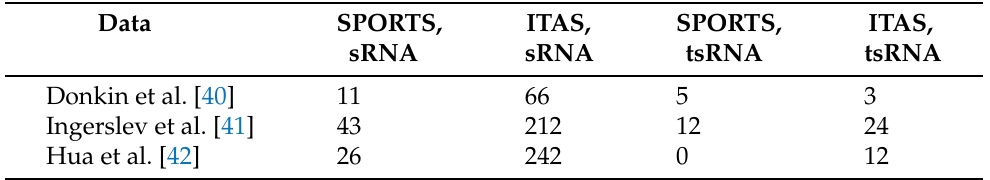
Table 6. Numbers of identified differentially expressed sRNA transcripts (sRNA) ( p -value < 0.05) and tRNA-derived small RNA (tsRNA) (adjusted p -value < 0.1) for case studies processed with SPORTS pipeline with default annotation vs. genome alignment (bowtie + Rsubread/kallisto) pipeline based on ITAS.